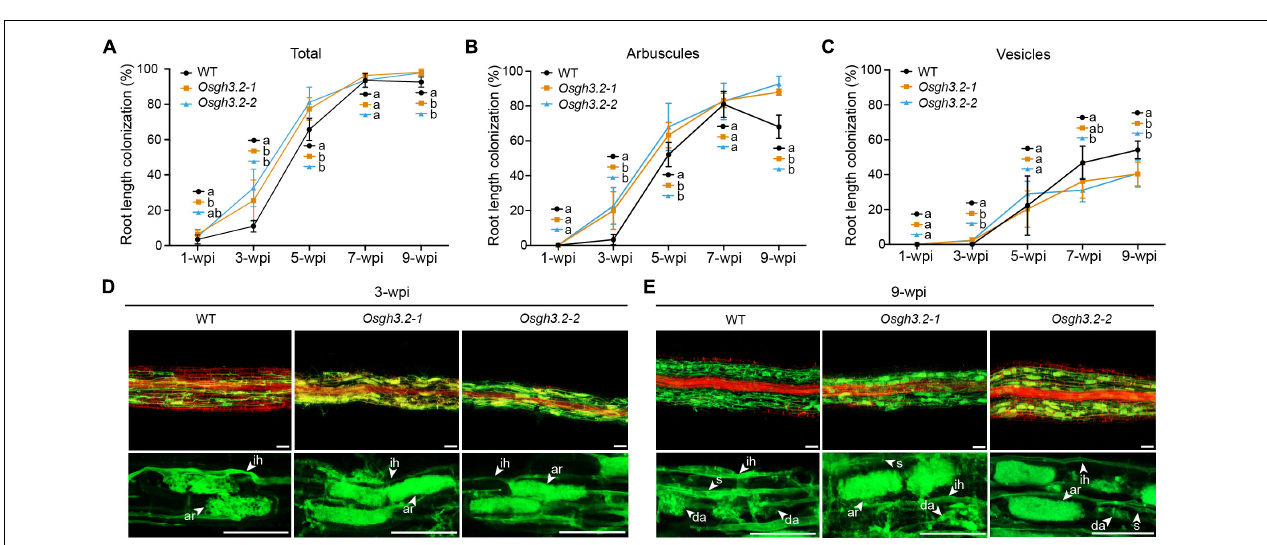
FIGURE 4 | The mycorrhizal phenotypes of Osgh3.2 mutants. (A–C) For both wild-type rice and the Osgh3.2 mutants, the total root length colonization rates (%) as well as the rates of specific fungal structures including arbuscules, and vesicles were determined by the gridline intersect method at 1-, 3-, 5-, 7-, and 9-wpi by R. irregularis. Data represent mean ± standard deviations (SD), n = 4 ∼ 6. Different letters indicate statistically significant differences (Student’s t -test, P < 0.05). (D,E) Laser scanning confocal images showing fungal structures stained by WGA-Alexa Fluor 488 (green) and plant cell walls stained by propidium iodide (red) in wild-type rice and the Osgh3.2 mutants at 3- and 9-wpi, respectively; ih, intraradical hyphae; ar, arbuscules; da, degenerating arbuscules; s, septa. scale bar = 50 µ